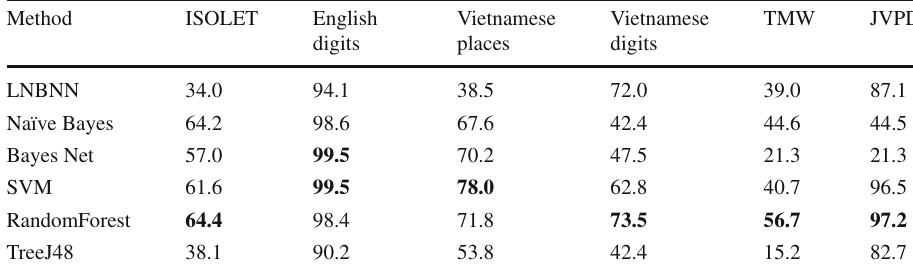
Bold values indicate highest value in the column Table 3 Average correct classification rate with different methods with SIFT